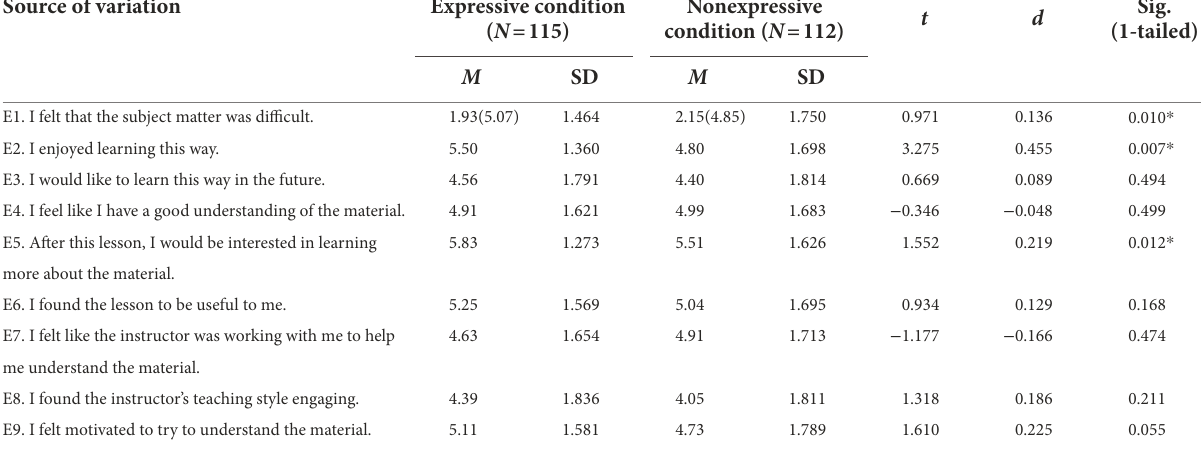
TABLE 3 Results of independent sample t-test of learning experience sub-items in experiment